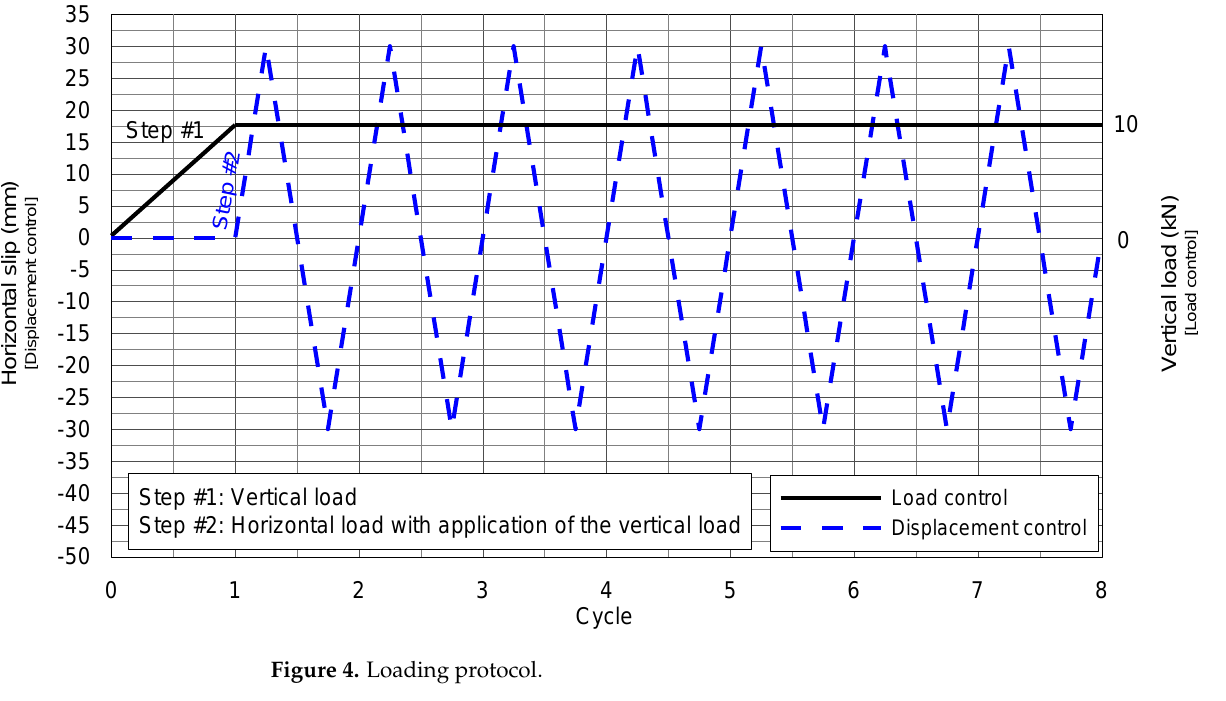
Figure 4. Loading protocol.